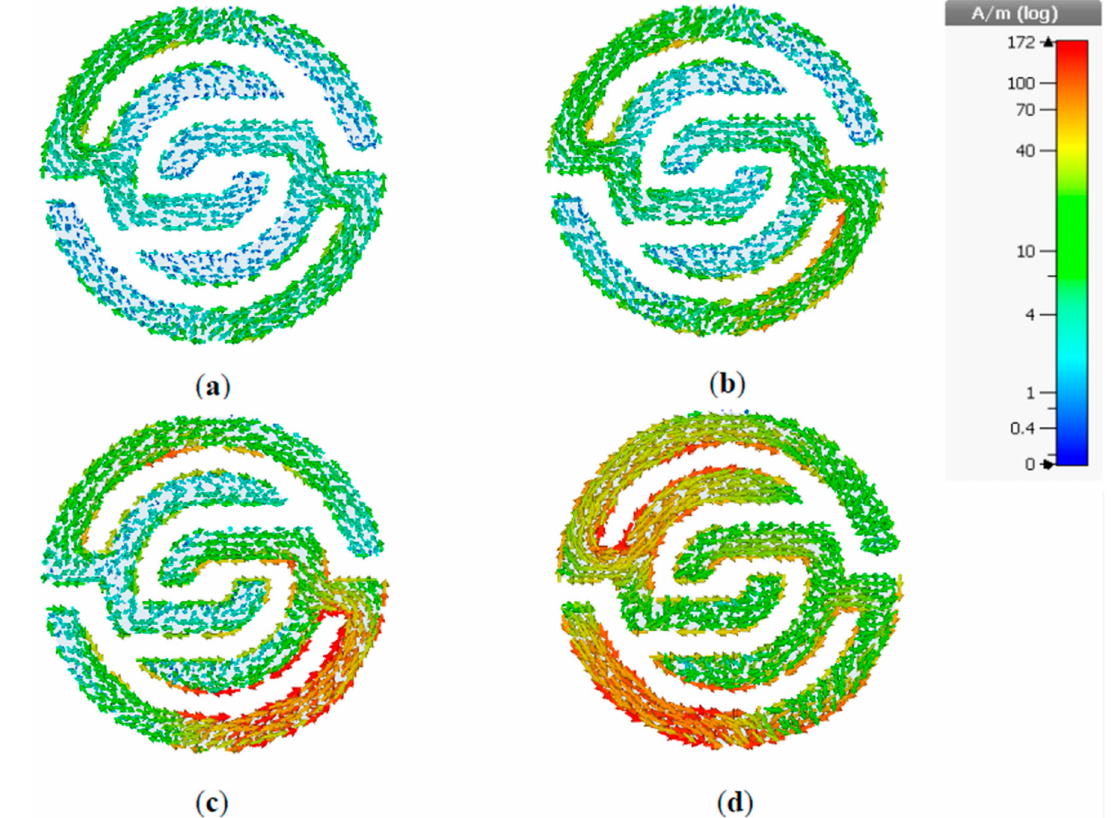
Figure 2. Surface current distribution at ( a ) 2.4; ( b ) 3.5; ( c ) 5.5 and ( d ) 10 GHz.